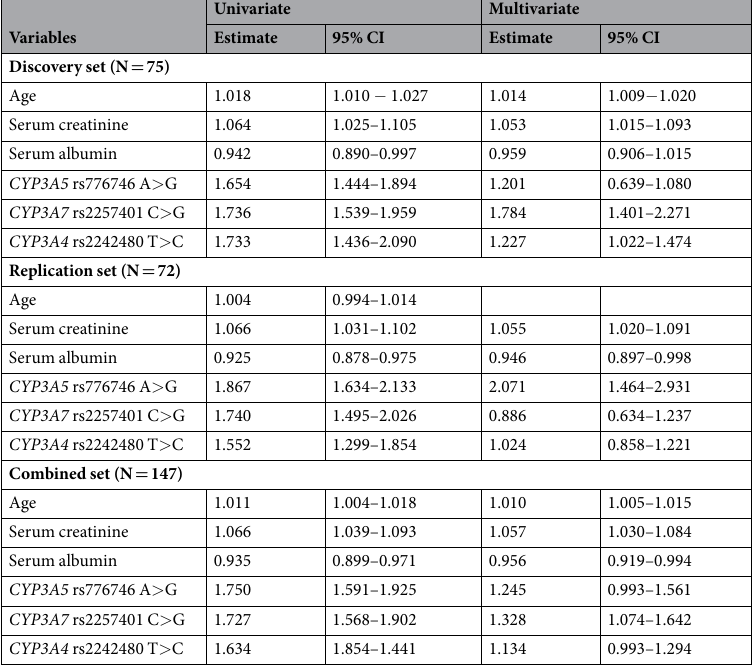
Table 2. Results from the final linear mixed model for tacrolimus dose-adjusted trough concentrations in kidney transplant